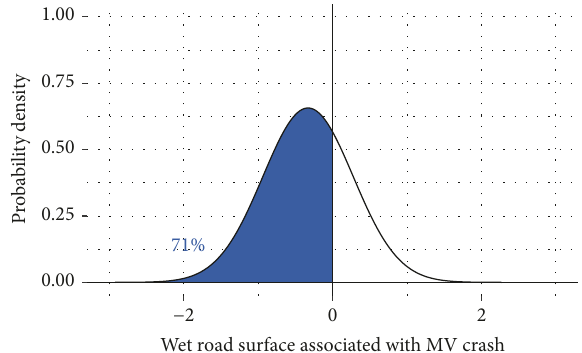
Figure 3: Distribution of wet road surface associated with MV